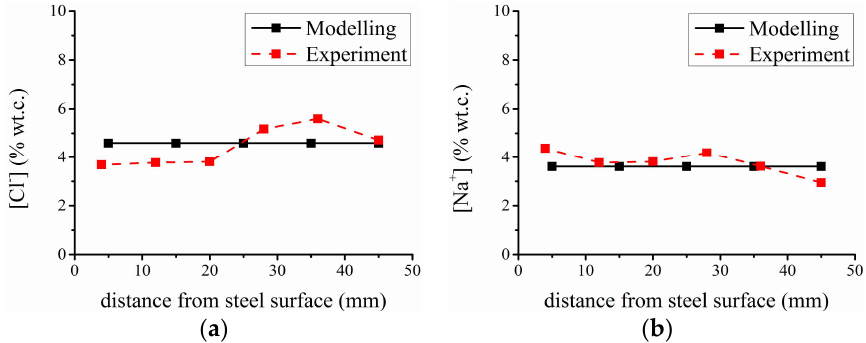
Figure 6. Comparison of the concentration profiles between modelling and the experimental test before the electrochemical treatment ( a ) Cl − ; ( b ) Na + .